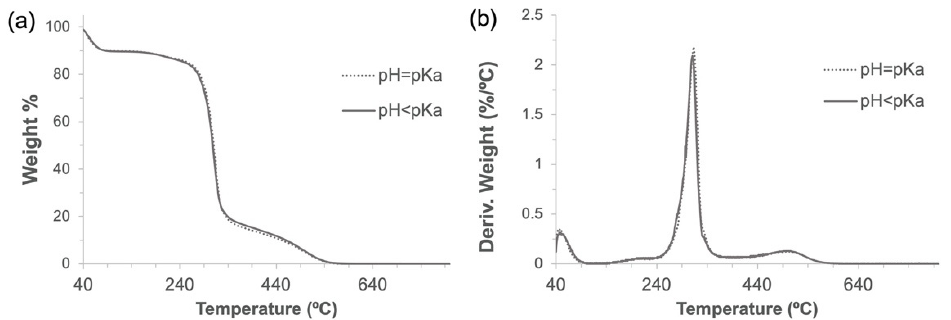
Figure 9. Thermogravimetric analyses ( a ) and their derivatives ( b ) of α -CD-NS washed at pH 6.9 and 6.0.